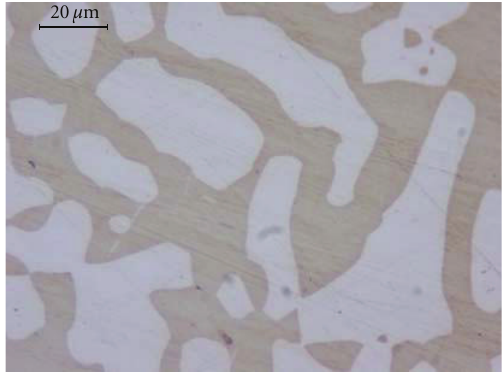
Figure 1: Microstructure of DSS, solution annealed at 1050 ◦ C for 1 hour (austenite in white, ferrite in